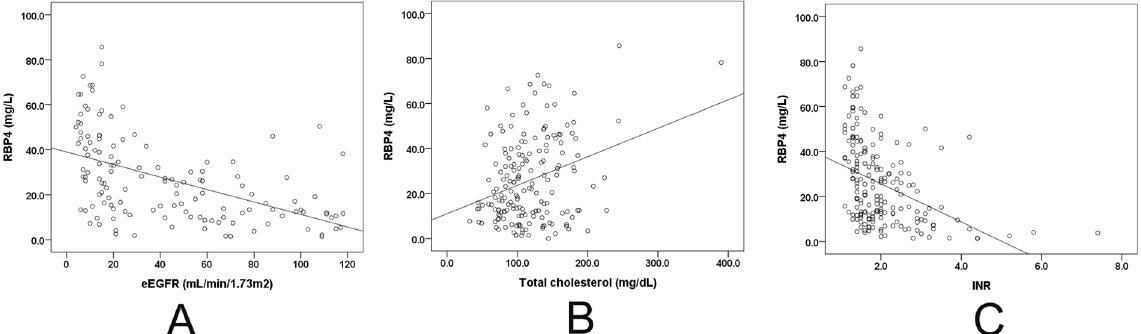
Figure 2. Regression plots for the associations between the baseline RBP4 levels and eGFRs ( A ), TC levels ( B ) and INRs of the prothrombin time ( C ). A, R 2 = − 0.462, p < 0.001; B, R 2 = 0.375, p < 0.001; C, R 2 = − 0.404, p < 0.001.